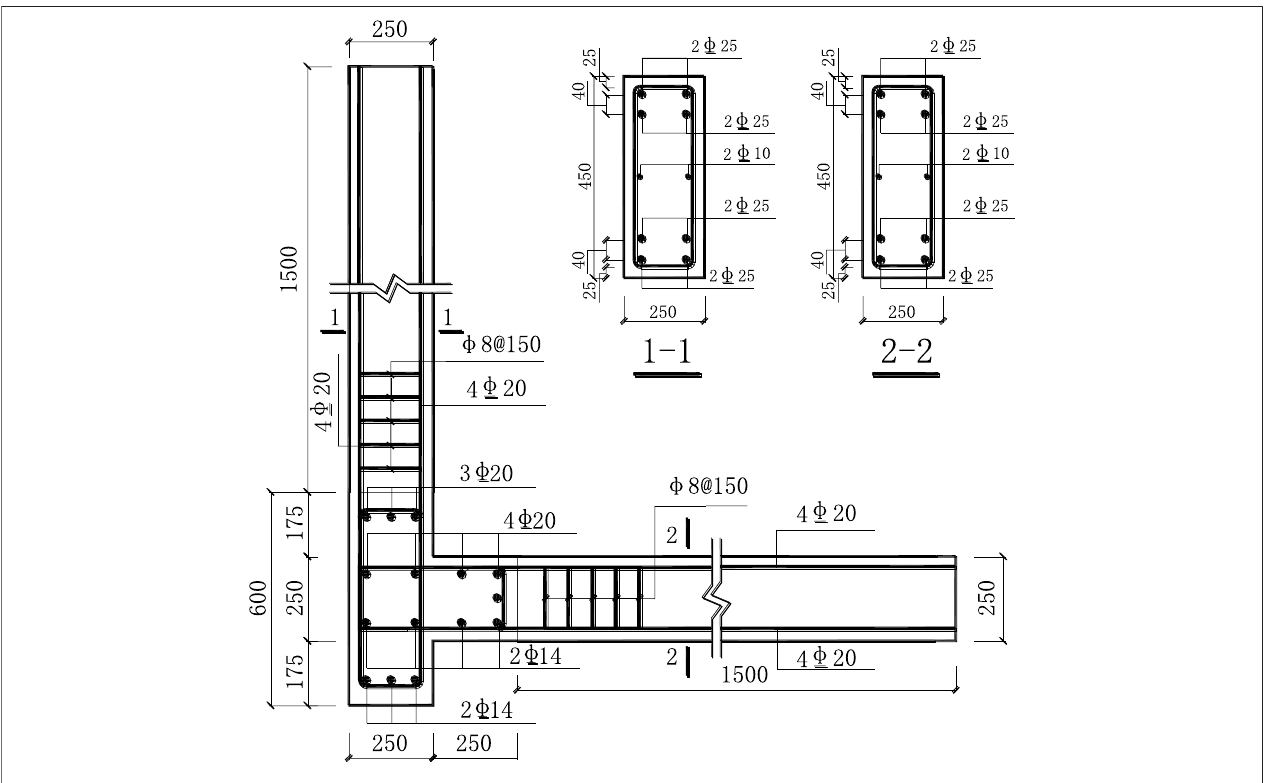
FIGURE 11 | Section of specimen JD-4 (Xiang et al., 2017; Xiang et al., 2019).